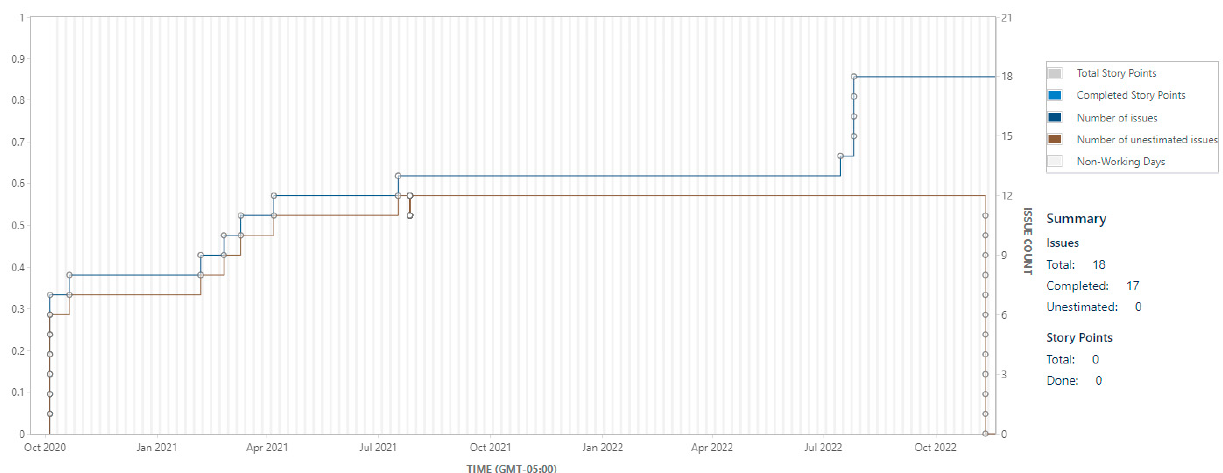
Figure 5. Jira Epic Report.